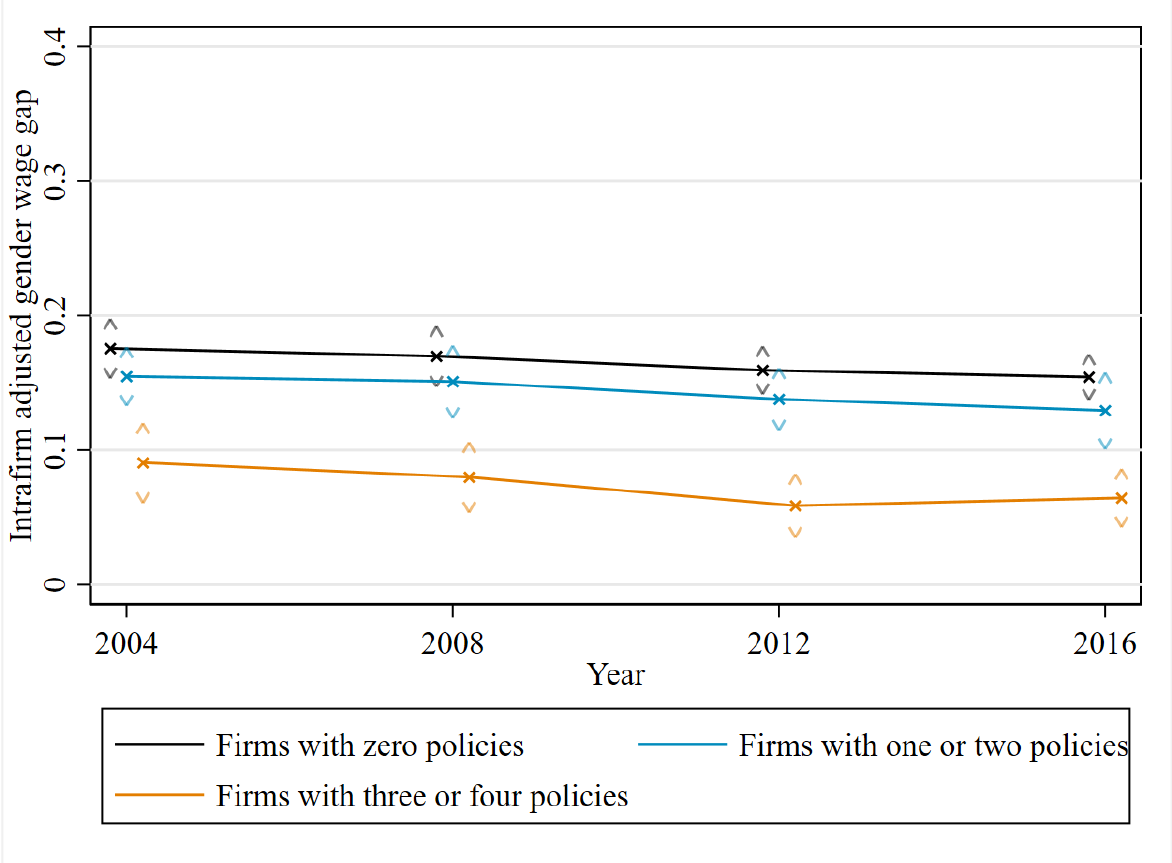
Figure 4: Intrafirm gender wage gap by number of organizational policies in firms. Notes: The gender wage gap is measured in log points. The adjusted gap is adjusted for the individual-level control variables, that is, work experience, its square, tenure, its square, migration status, three dummies for education, 13 dummies for occupation, and firm fixed effects. The number of observations is 956,777 employee observations in 1,415 firms. To improve clarity, the point estimates, that is, the x symbols, of different lines are staggered, although each point estimate is measured at the same point in time. The whiskers represent the 95 percent confidence interval. Standard errors are clustered at the firm level. Source: Own calculations using the LIAB QM2